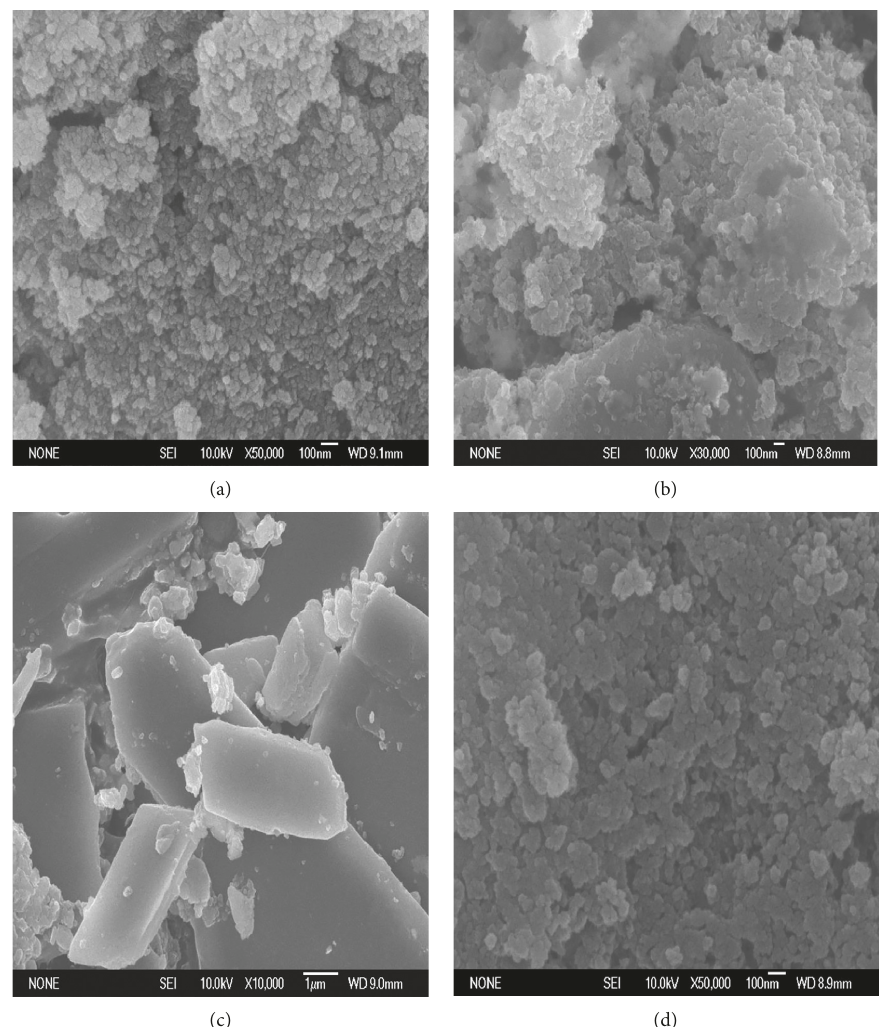
Figure 3: SEM images of as-synthesized compounds: (a) Mg-Al(OH) Ca-Al(OH) 2 PO 4 PF 6 ( 4